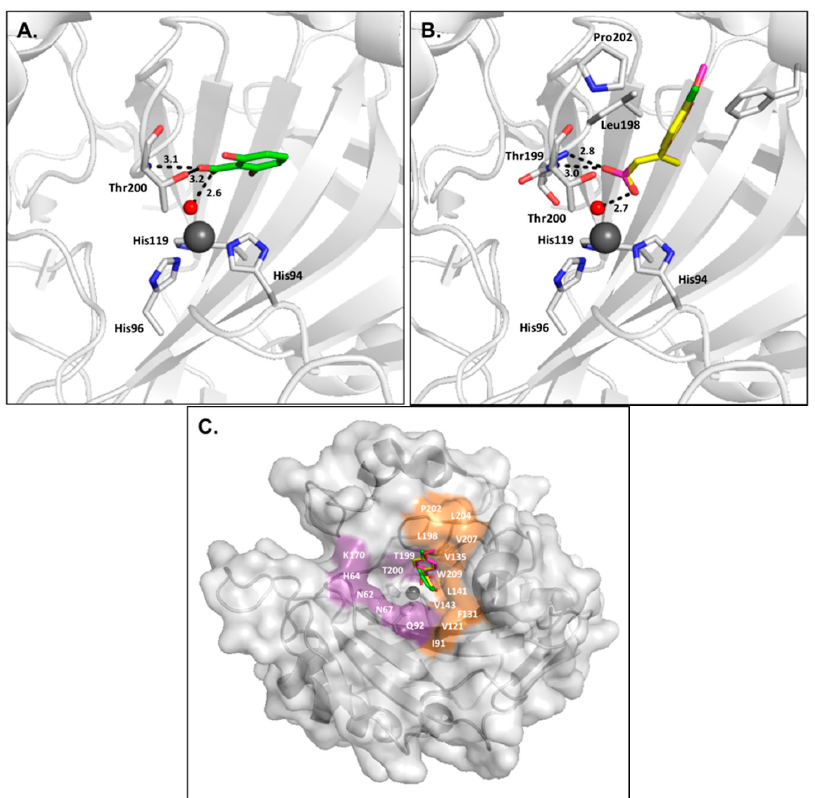
Figure 6. ( A ) CA ΙΙ ( gray ) in complex with 2,6-dihydroxybenzoic ( green , PDB:4E3F) [40]; ( B ) CA ΙΙ ( gray ) in complex with ligands ( E )-3-(4-methoxyphenyl)but-2-enoic acid ( magenta ) and ( E )-3-(4-chlorophenyl)but-2-enoic acid ( yellow ) (PDBs: 5FNM and 5FLS, respectively) [44]; ( C ) Overlay of carboxylic acid–based compounds in CA ΙΙ